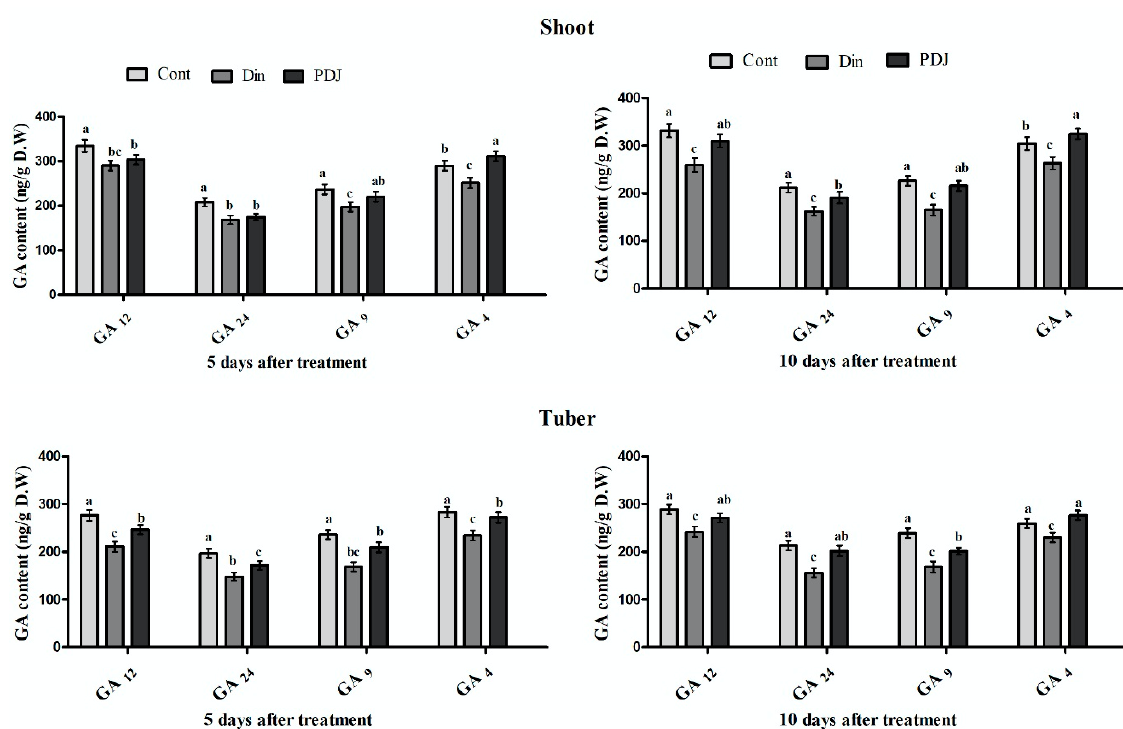
Fig. 4: Effect of treatments on GA content of shoots, stolons, and tubers per each treatment after 5 and 10 days after sowing (Cont; Control, Din; Diniconazole, PDJ; Prohydrojasmon). The differences between mean values were determined using a DMRT at P < 0.05. The results were graphically presented using GraphPad Prism (version 5.0, San Diego, CA, USA). The SAS 9.1 was used for DMRT